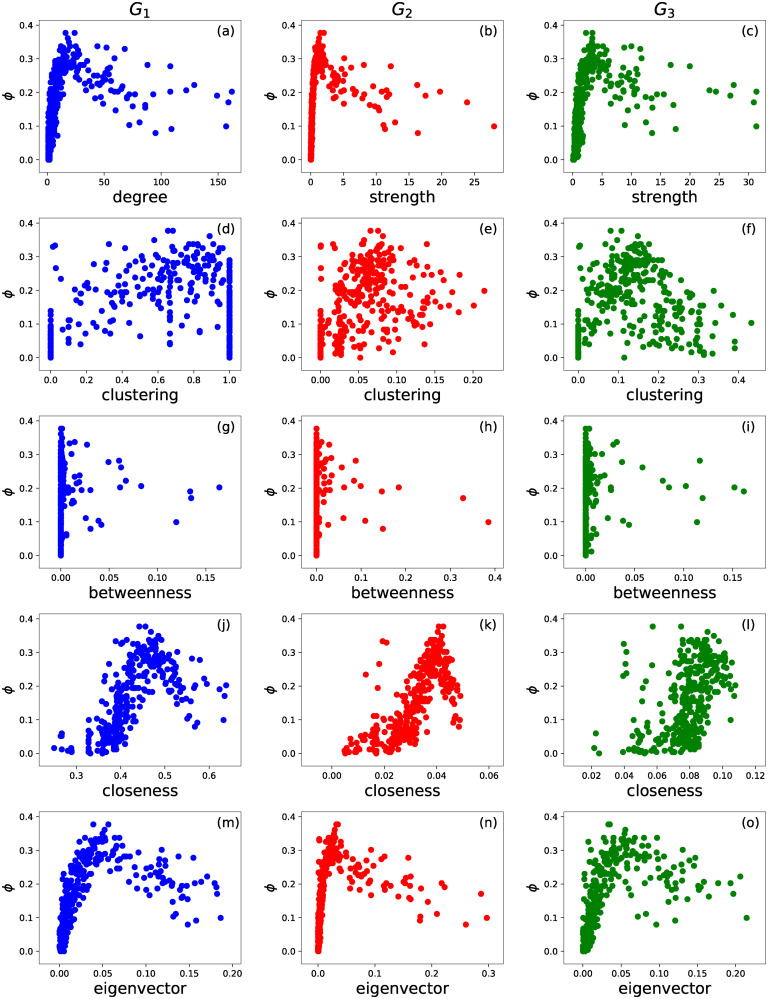
Airport vulnerability versus a nodal centrality metric.The scatter plot of airport vulnerability ϕ versus node strength (a,b,c), clustering coefficient (d,e,f), betweenness (g,h,i), closeness (j,k,l) and eigenvector (m,n,o) centrality in network G1 (first column, blue color), G2 (second column, red color) and G3 respectively.